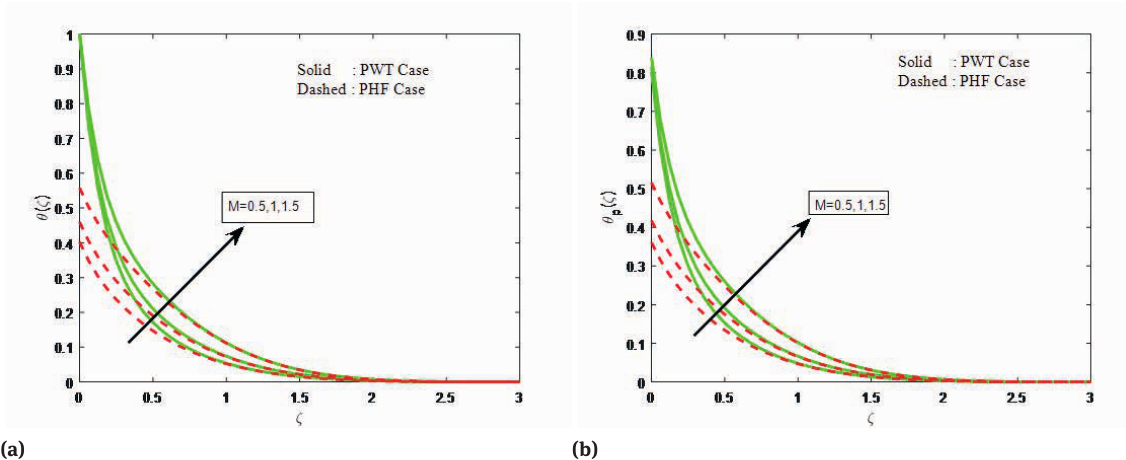
Fig. 6: a,b) Temperature profiles with varying magnetic parameter (M).